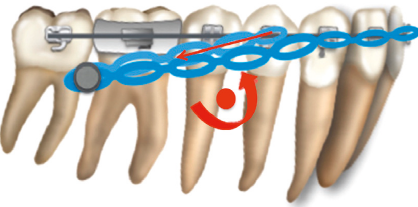
Figure 10: Schematic illustration of the en masse mandibular distalization mechanics. Distalization force applied to the miniplate is above the center of the mandibular dentition. This leads to counterclockwise rotation of the mandibular teeth which helps in correcting the anterior open